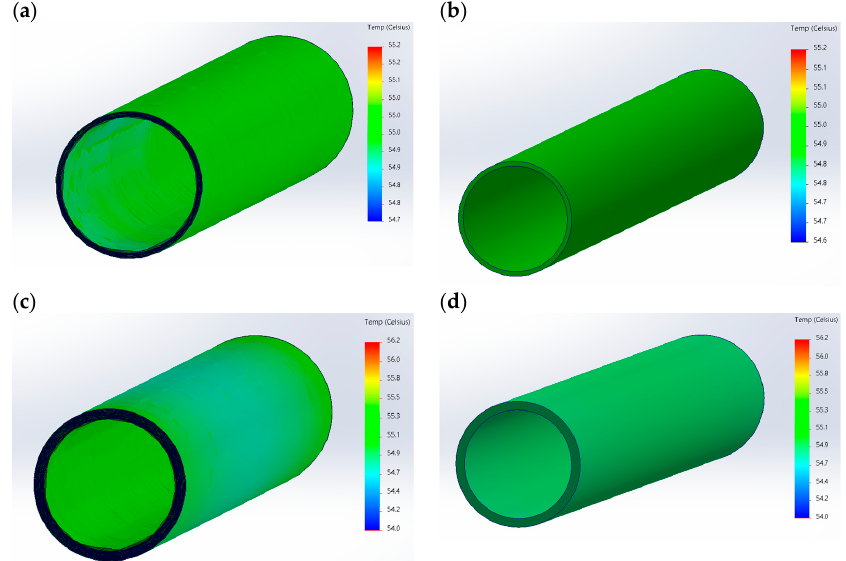
Figure 8. ( a ) Cylinder made of 5 layers of aluminum and polypropylene (simulation time 805 s), ( b ) model made of uniform material corresponding to 60 layers of aluminum and polypropylene (simulation time 9 s), ( c ) cylinder made of 10 layers of aluminum and polypropylene (simulation time 1220 s), and ( d ) model made of uniform material corresponding to 60 layers of aluminum and polypropylene (simulation time 11 s). The thickness of one layer of aluminum is 20 µ m, and polypropylene is 10 µ